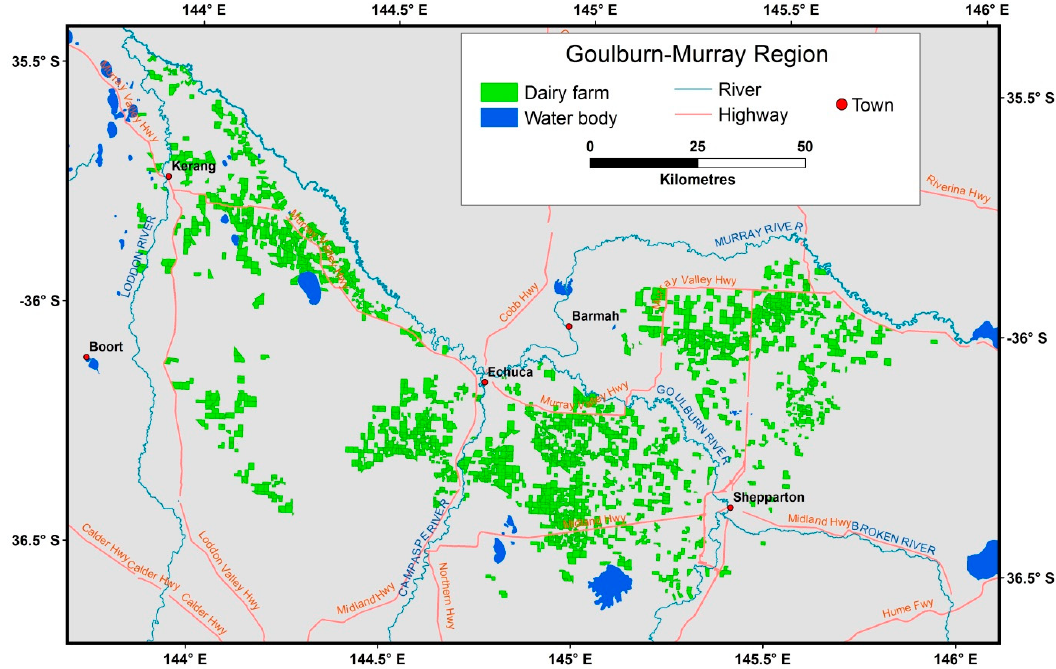
Figure 1. Location of dairy farms in the Goulburn-Murray Irrigation District.